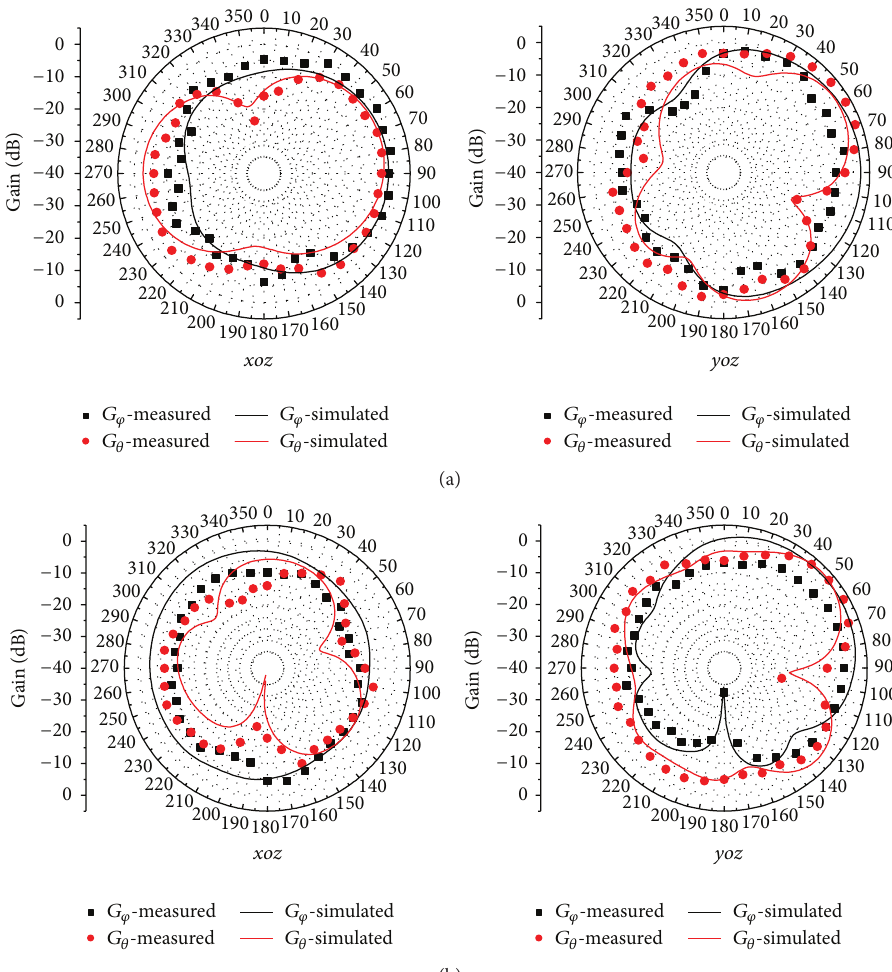
Figure 9: Measured and simulated radiation patterns. (a) At 1.9GHz; (b) at 2.6GHz.